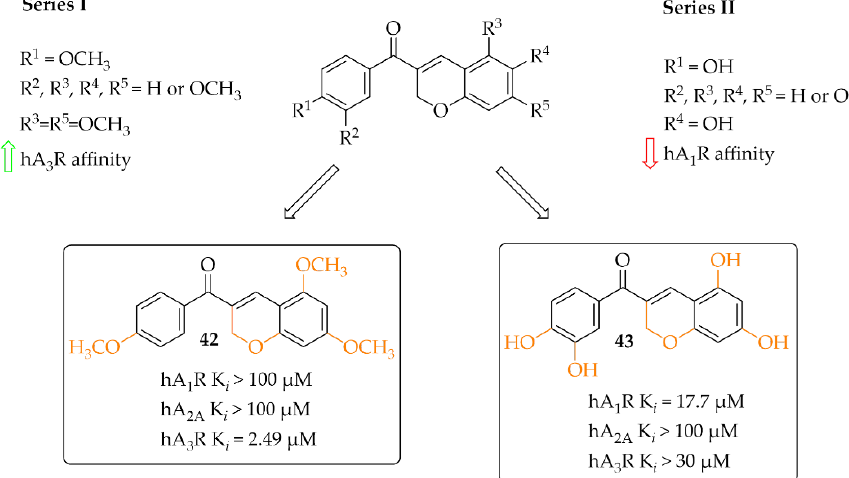
Figure 32. Coumarin-based chalcones with the most potent compounds in the series [70].